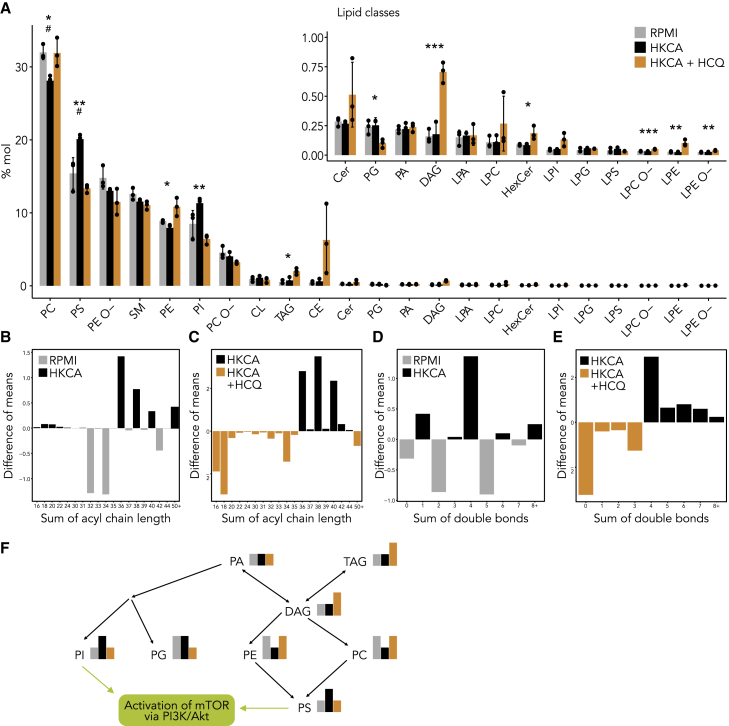
HCQ Affects the Monocyte Lipidome(A–E) PBMCs were stimulated with HKCA, HKCA+HCQ, or RPMI as a control for 24 h. Subsequently, monocytes were purified and analyzed for their lipid content using mass-spectrometry-based shotgun lipidomics (n = 3 per treatment group).(A) Abundance of lipid classes as the molar percentage of all lipids per treatment group. HKCA alone induced a significant decrease in phosphatidylcholines and an increase in phosphatidylserines compared to control cells, whereas HCQ induced significant changes in multiple lipid classes compared to HKCA-treated cells. The inserted graph shows low-abundant lipids on a smaller scale.(B and C) Analysis of acyl chain length of all lipids identified. HKCA training resulted in lipids with longer acyl chains than those of the control. HCQ induced even shorter acyl chains than the control.(D and E) Analysis of double bonds in all lipids identified. HKCA training did not cause marked effects compared to control cells. HCQ-treated cells contained more lipids with fewer double bonds than HKCA-trained cells.(F) Schematic representation of lipid metabolism showing lipid classes that are affected by either HKCA or HCQ treatment.Data are presented as mean ± SEM; #p < 0.05 between control and HKCA; *p < 0.05, ∗∗p < 0.01, ∗∗∗p < 0.001 between HKCA and HKCA+HCQ; one-way ANOVA with Tukey post-test.